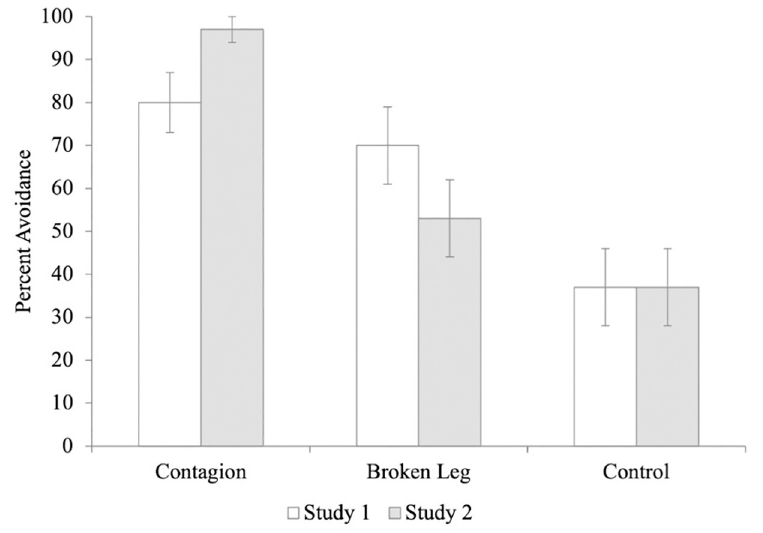
Fig 1. Percentage of adults who avoided the target confederate in Experiments 1 and